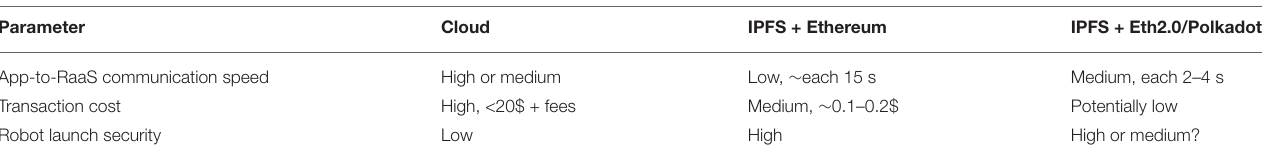
TABLE 1 | Comparison between cloud and decentralized technologies for